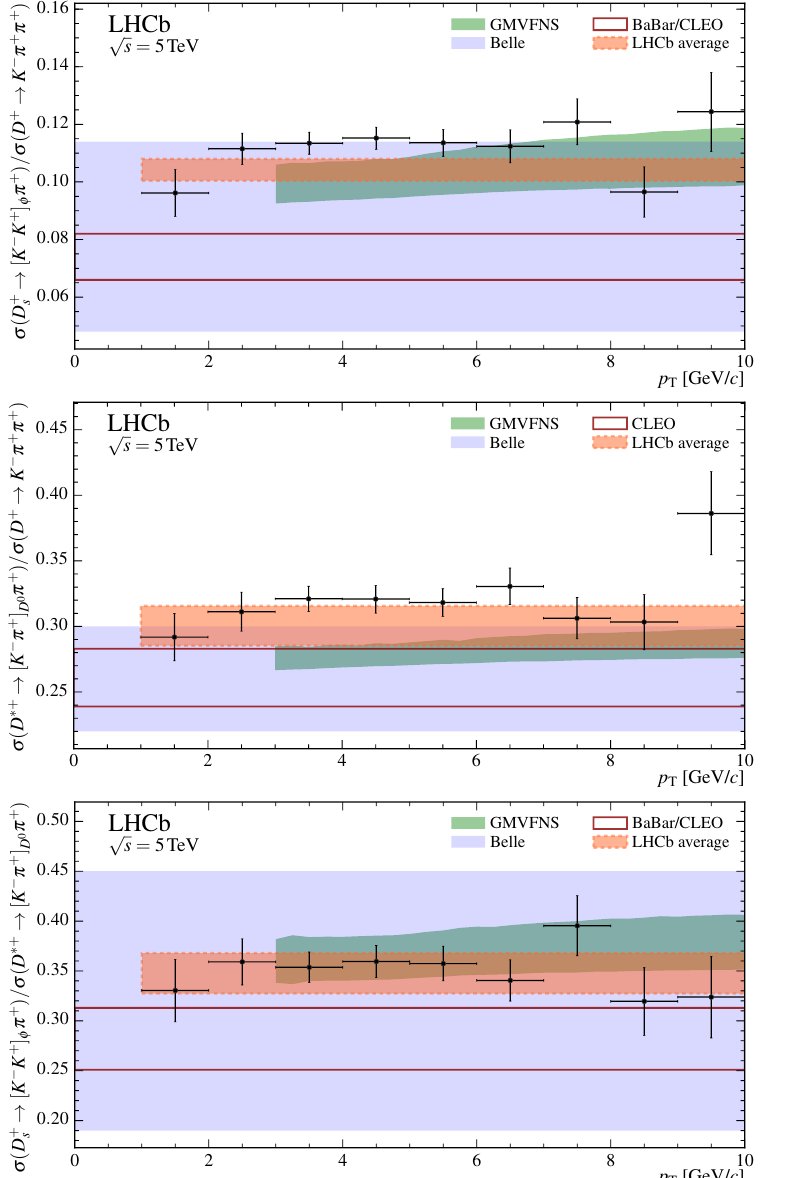
Figure 9. Ratios of the measurements of cross-section times branching fraction of (top) D (cid:3) + , and (middle) D + mesons with respect to D + cross-sections, and (bottom) D + s The bands indicate the corresponding ratios computed using measurements from e + e (cid:0) collider experiments [41{43]. The ratios are given as a function of p T integrated over y . The notation (cid:27) ( D f ) is shorthand for (cid:27) ( D ) ( D f ). ! (cid:2) B !